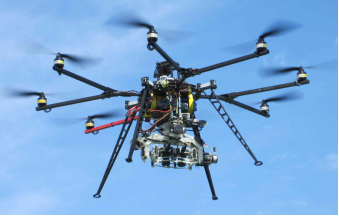
Figure 3: The camera system on board the